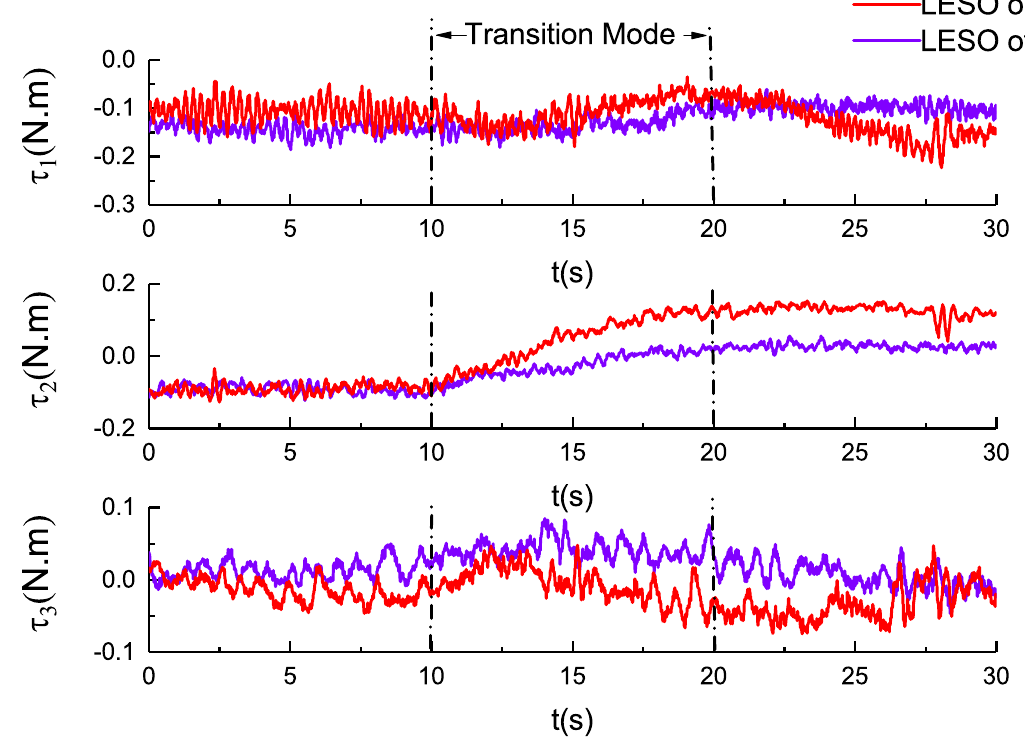
Figure 12. Control torque with the LESO on and off in transition